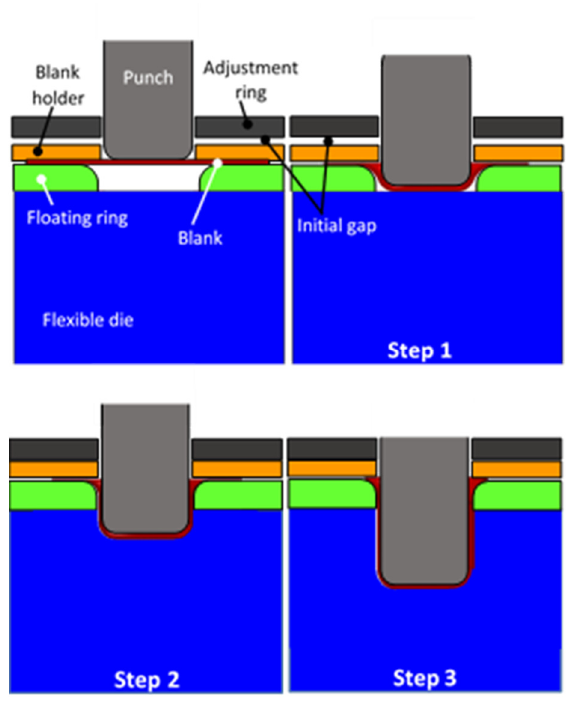
Fig. 1. Forming system of the proposed technique.